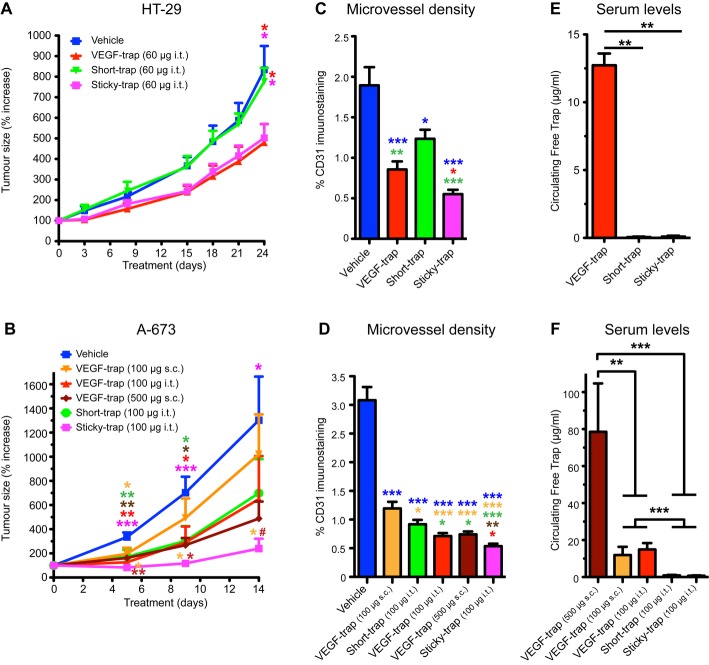
Characterization of recombinant traps in vivo antiangiogenic activity in xenograft models.A Tumour growth kinetics of HT-29 xenografts. Treatment (30 μg per tumour, intratumorally injected; two-times per week) initiated 1 week after tumour implantation, once tumours reached an average size 100 mm3. Error bars represent s.e.m. (n = 12; *P < 0.05, one-way ANOVA).B Tumour growth kinetics of A-673 xenografts. Treatment (50 μg per tumour, intratumorally injected, or 100/500 μg subcutaneously injected; three times per week) initiated 1 week after tumour implantation, once tumours reached an average size of 50 mm3. Error bars represent s.e.m. (n = 8; ***P < 0.001, **P < 0.01, *P < 0.05, one-way ANOVA).C, D Microvascular density of HT-29 and A-673 xenografts, respectively. Paraffin sections (Supplementary Figs S8 and S9) were immunostained with an anti-CD31 antibody (***P < 0.001, **P < 0.01, *P < 0.05, one-way ANOVA).E, F Circulating levels of free traps. Serum from HT-29 (E) and A-673 (F) tumour-bearing mice, treated with various traps, was collected at day 24 and 14, respectively (***P < 0.001, **P < 0.01, one-way ANOVA).Source data are available online for this figure.